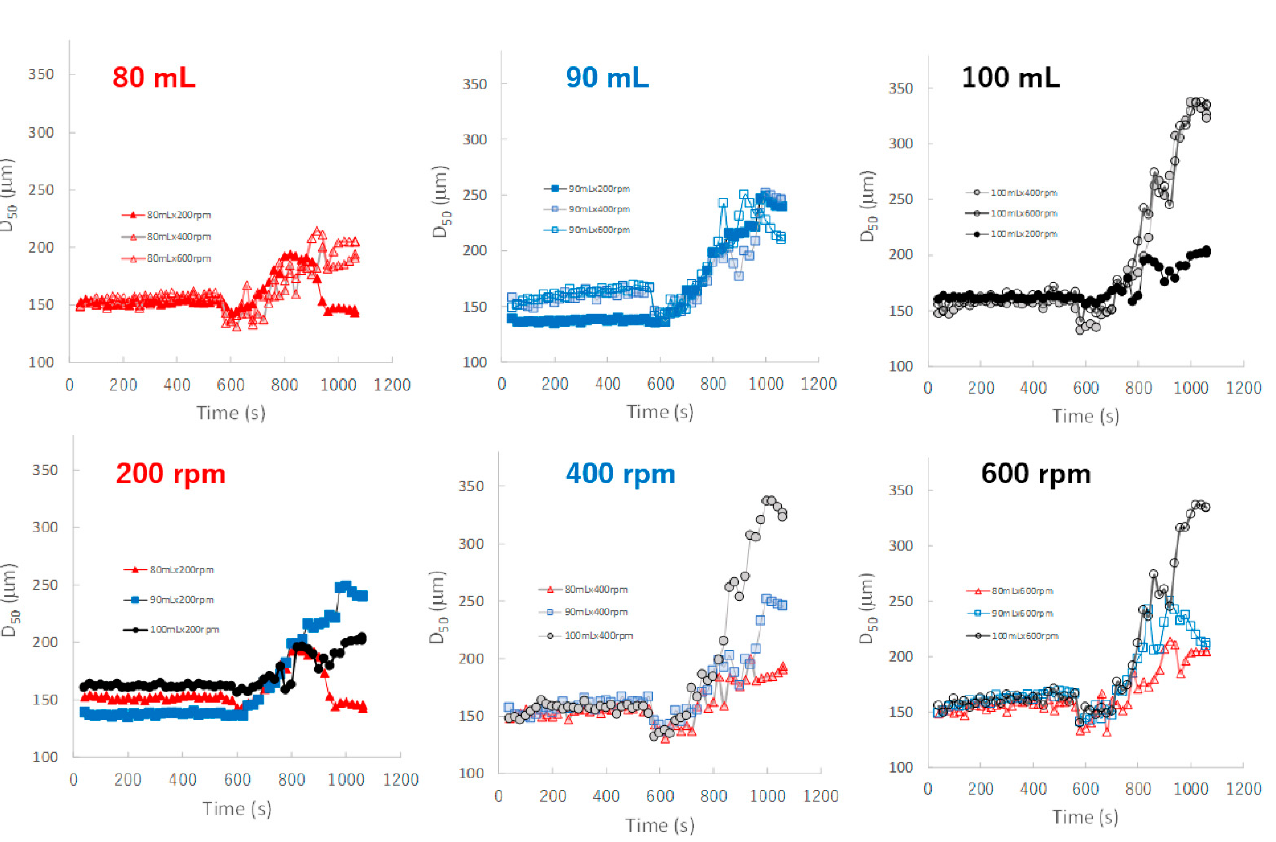
Figure 8. The effect of adding water and increasing stirring speed on real-time D50 profiles of the granules predicted using the NIRS/PLSR